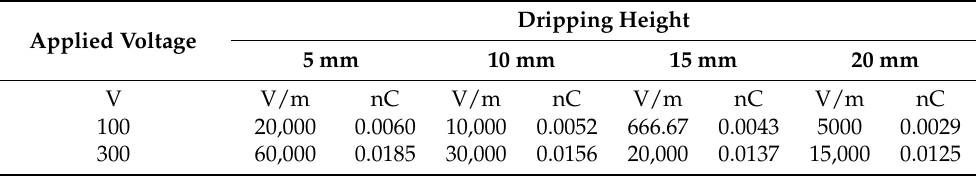
Table 1. The net charge amount to an electrified ethanol droplet.